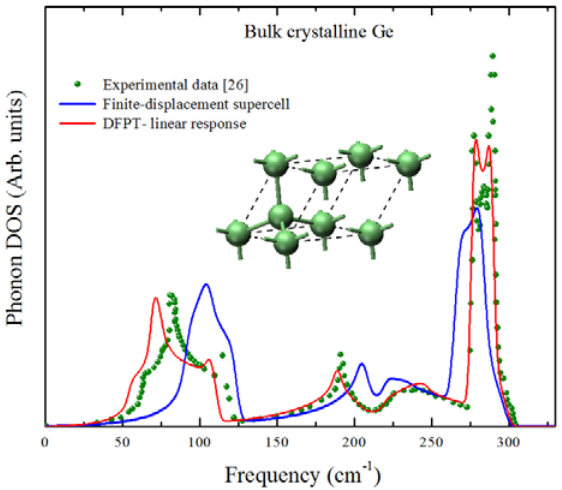
Figure 2. The phonon density of states (DOS) of crystalline Ge using two first principles approaches, finite displacement-supercell (blue line) and DFPT (red line), compared with the experimental results taken from